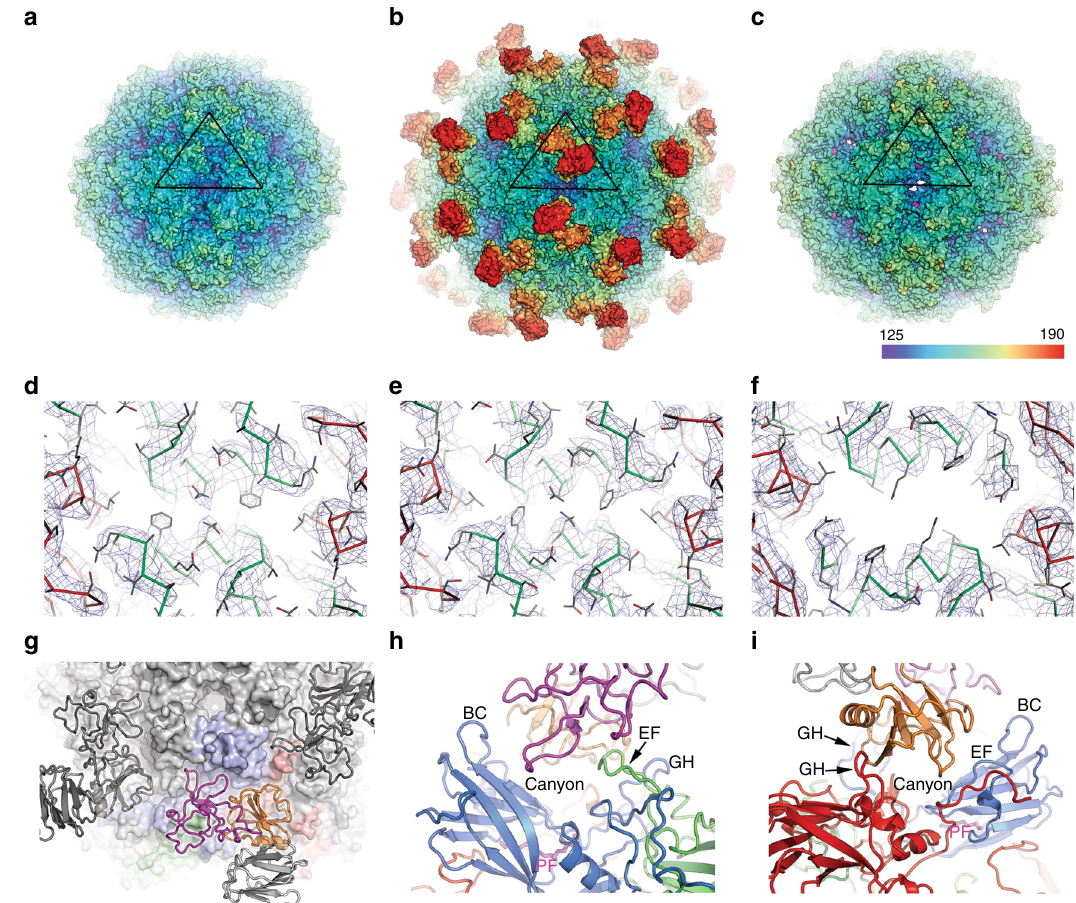
Fig. 1 Overview structures of CV-A10 and its receptor complex. Radially coloured surface representations of mature CV-A10 virus ( a ), CV-A10/KRM1 complex ( b ) and expanded CV-A10 A-particle ( c ). The fi rst ordered residue of the VP1 N-terminus is coloured in magenta showing where it externalizes in c . Electron potential maps at icosahedral twofold axis of the mature CV-A10 ( d ), CV-A10/KRM1 complex ( e ) and CV-A10 A-particle ( f ). CV-A10/KRM1 interacting across the canyon from above ( g ) where a virus pentamer is drawn as a grey surface with one icosahedral pentameric subunit coloured with VP1 blue, VP2 green and VP3 red. KRM1 is drawn as a cartoon with the domains colour coded: KR magenta, WSC orange, CUB grey, adjacent receptors are colour coded in grey. Interaction of one virus protomer with KRM1 from the side closest to the KR domain ( h ), virus and receptor drawn as a cartoon keeping the same colours as in g . Interaction of one virus protomer with KRM1 from the side closest to the WSC domain ( i ), drawn as for h